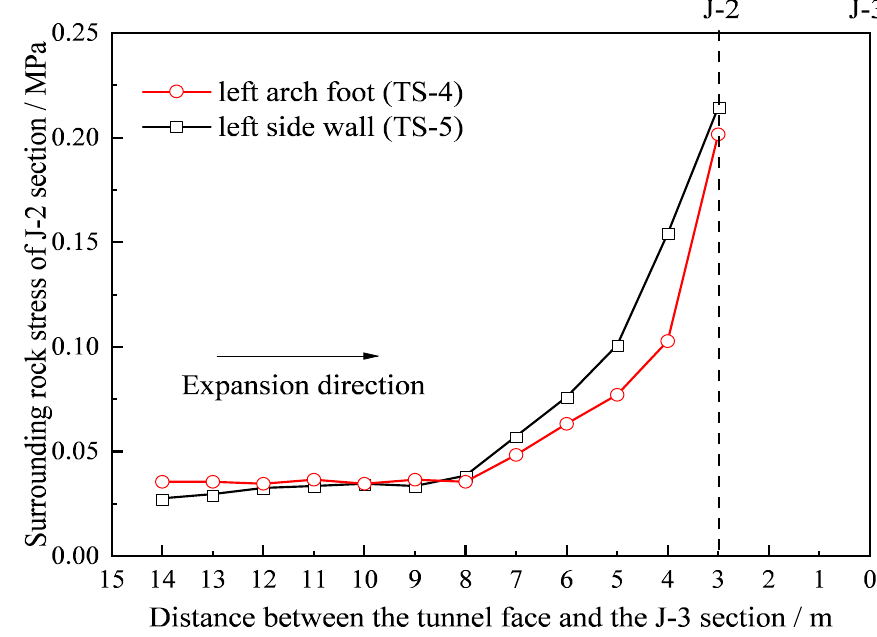
Figure 5. Stress change curve of J-1 section.